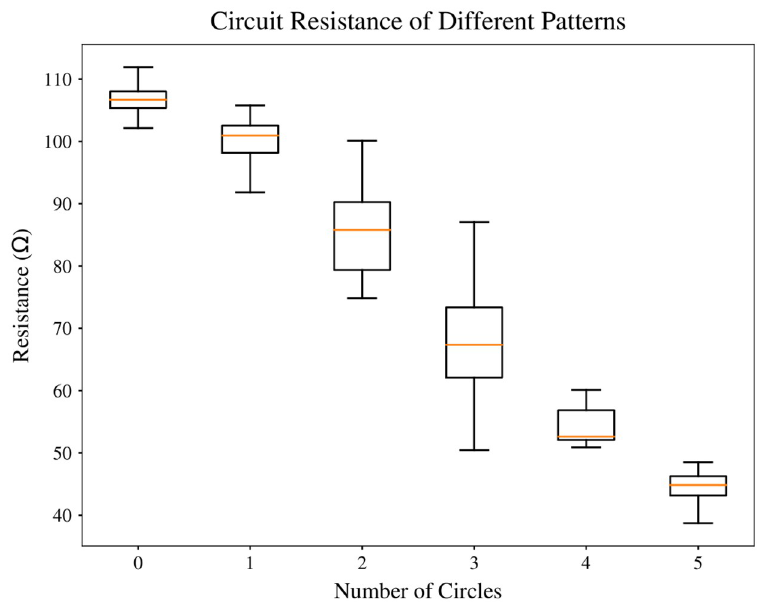
Fig 5. Circle number versus resistance. The overall resistance of connections decreases as there are more circles in the patterns. Significant reduction in resistance happens with 3 or more circles as more bridge circuits are created when circles intersect with each